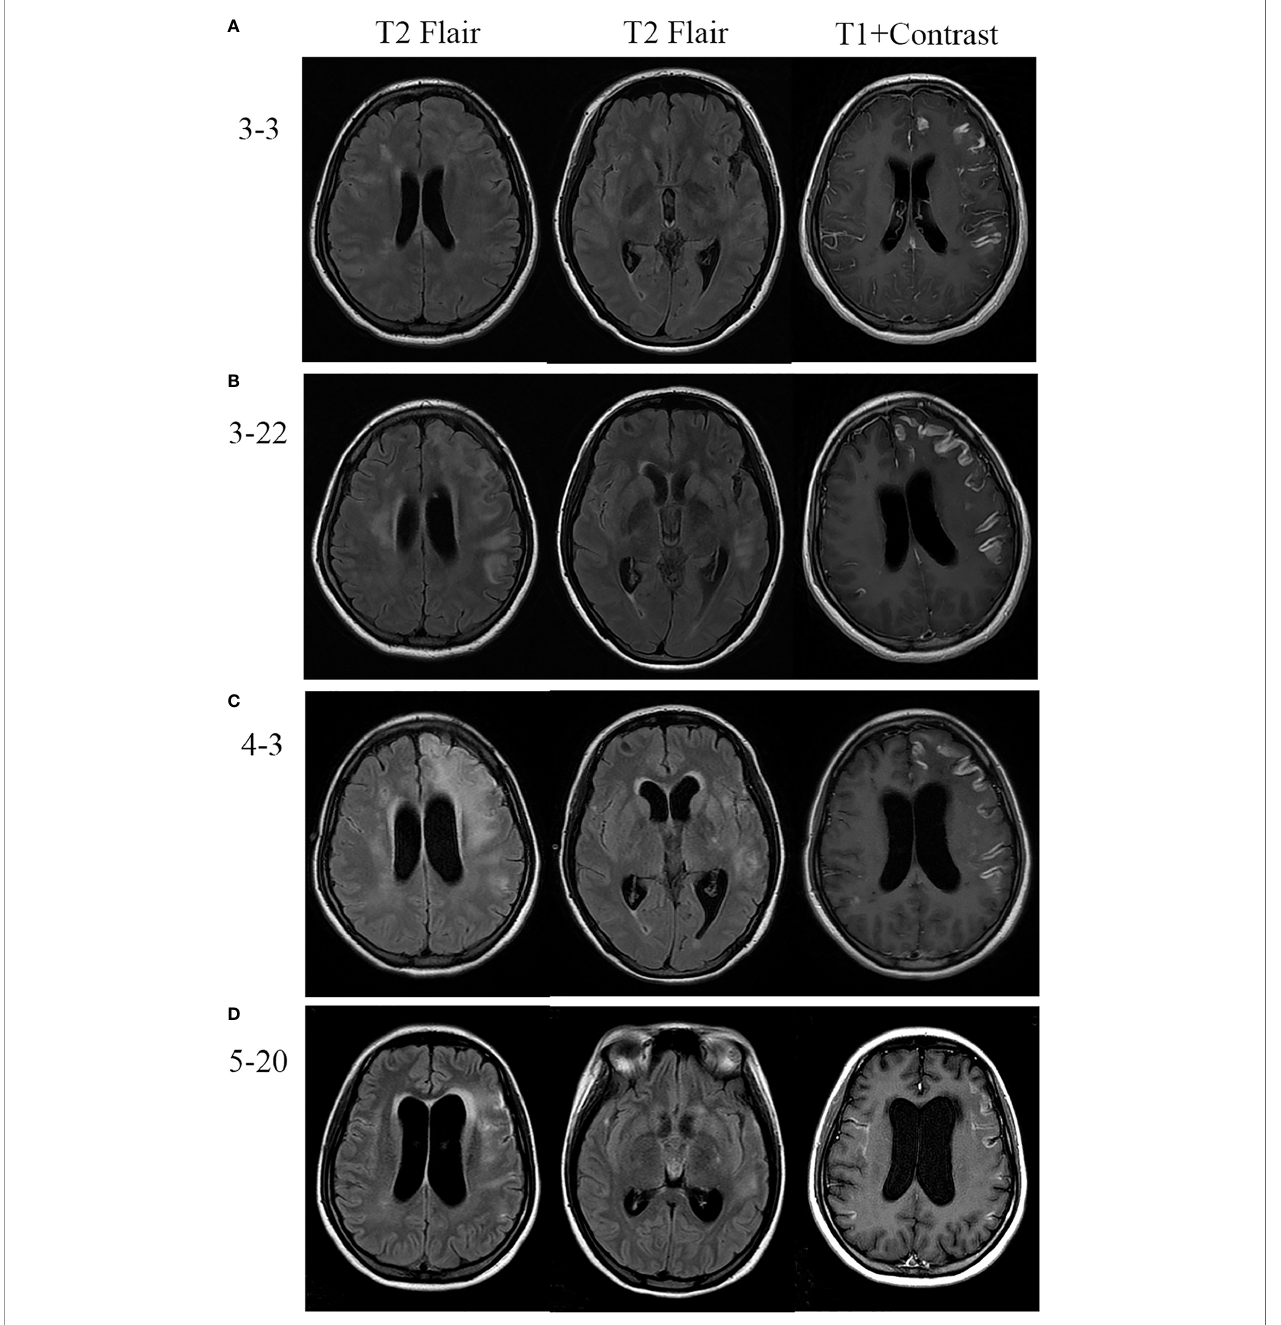
FIGURE 2 | Brain MRI of the patient. (A) MRI revealed diffuse hyperintensities on fl uid attenuated inversion recovery (FLAIR) imaging, accompanied by meningeal enhancement on the T1 contrast image. (B, C) Repeated MRI revealed that lesions were enlarged and meningeal enhancement was even more obvious after effective antibiotic therapy and induced labor. (D) Follow-up MRI showed marked improvement after corticosteroids